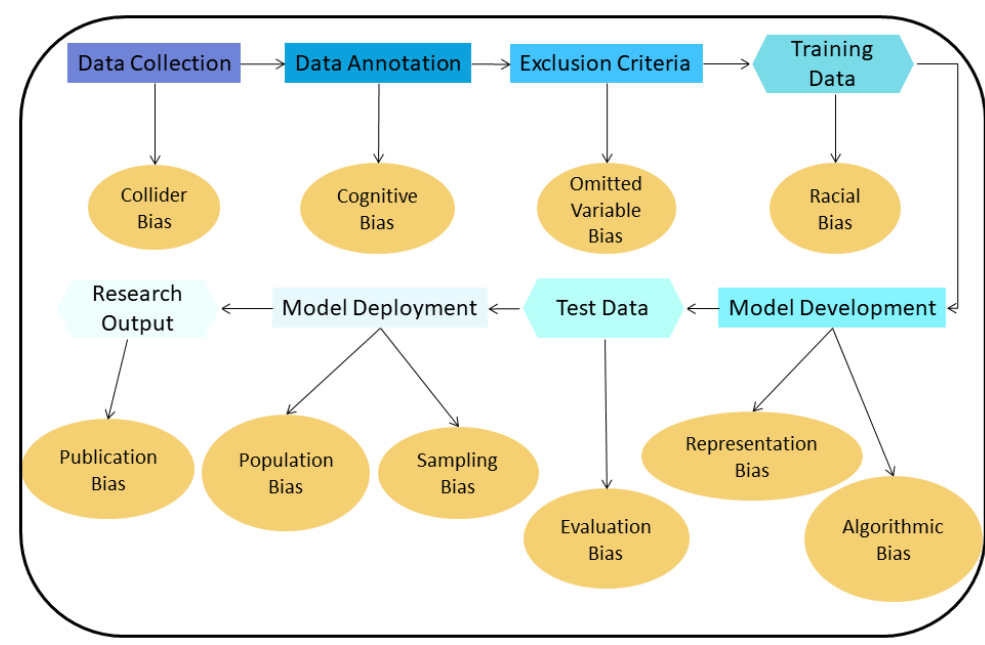
Figure 3. Biases introduced in the different phases of AI model development for lung nodule detection and